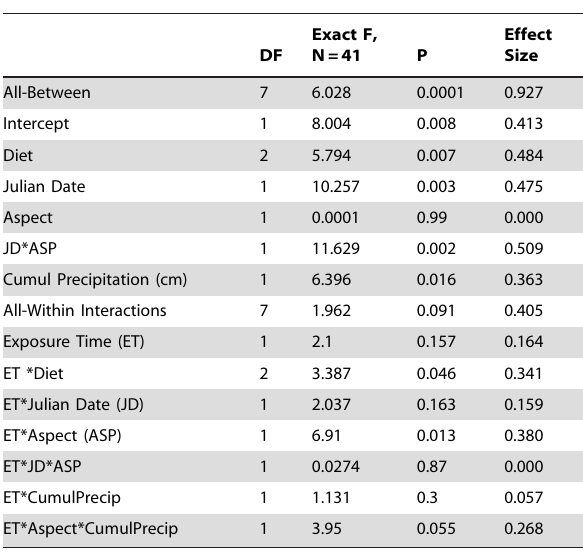
Table 2. Results from a repeated measures MANOVA, showing between- and within- sample effects of diet, Julian date, aspect (100 m ave), precipitation and their interactions with exposure time, on fecal glucocorticoid concentrations [log10(x +